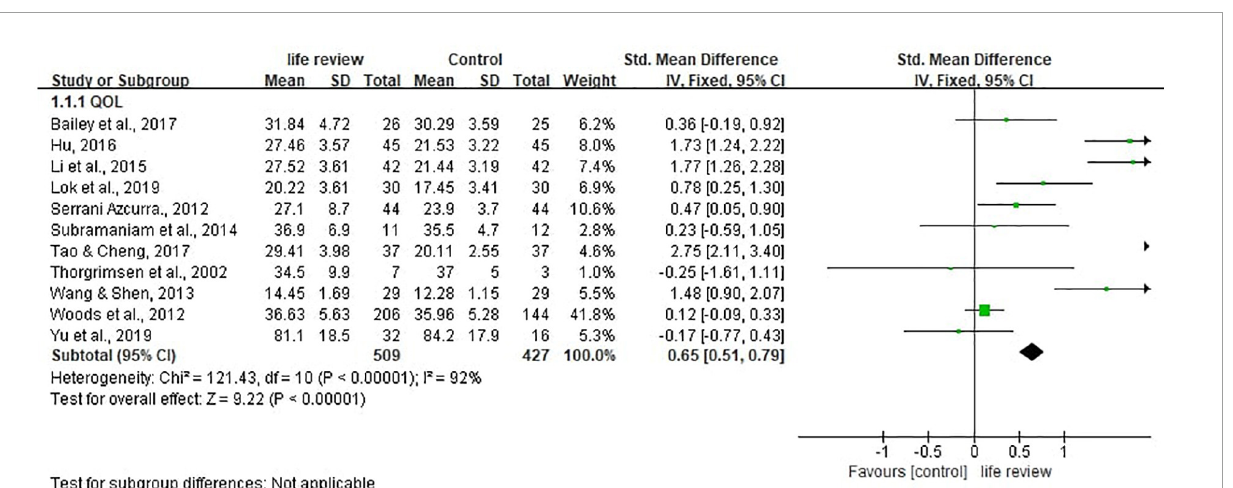
FIGURE5 Effect size of the intervention group versus the control group on quality-of-life rating scores.